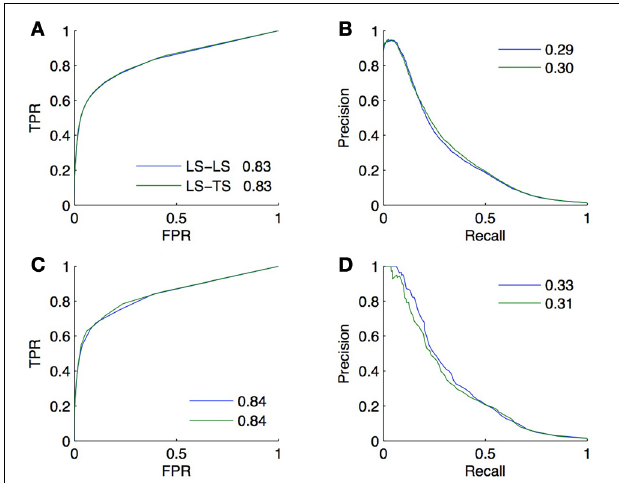
FIGURE 7 | Comparison of the CV estimates of the LS × LS and LS × TS scores, ROC curve in (A) and PR curve in (B), with true score values for the same two families of predictions, ROC curve in (C) and PR curve in (D). AUROC and AUPR values are found in the